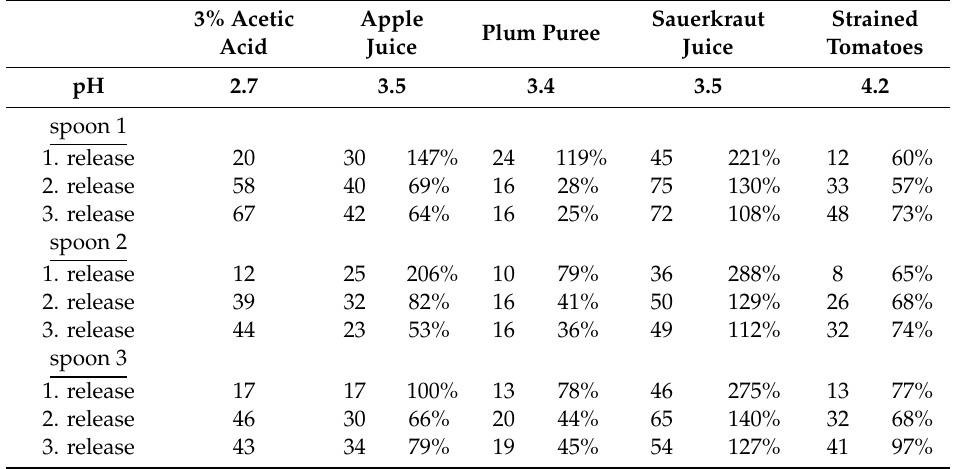
Table 1. Release of melamine (mg / dm 2 ) into acidic foods at hot plate conditions (2h@100 ◦ C) and the ratio (%) of that release compared to 3% acetic acid.